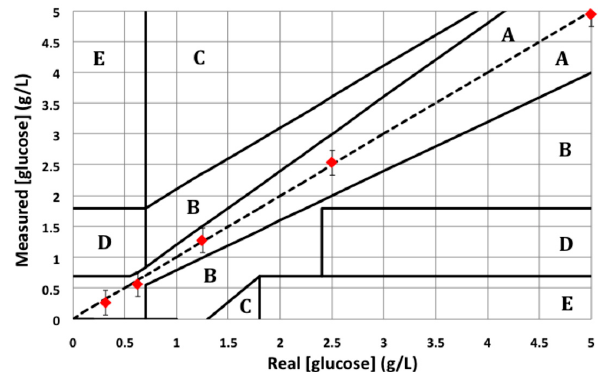
Figure 7. Clarke error grid established with the lowest five glucose solutions measured on the presented biosensor.